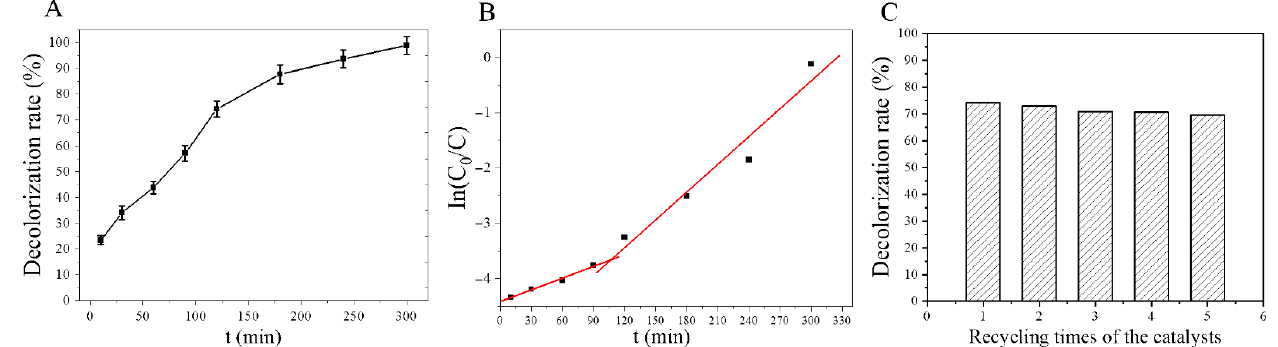
Figure 6. Visible light photocatalytic effect of the TiO 2 /Ag[BMIM]Cl changed with illumination time ( A ), the first − order − kinetic plots for TiO 2 /Ag[BMIM]Cl ( B ) and reusability performance ( C ) .